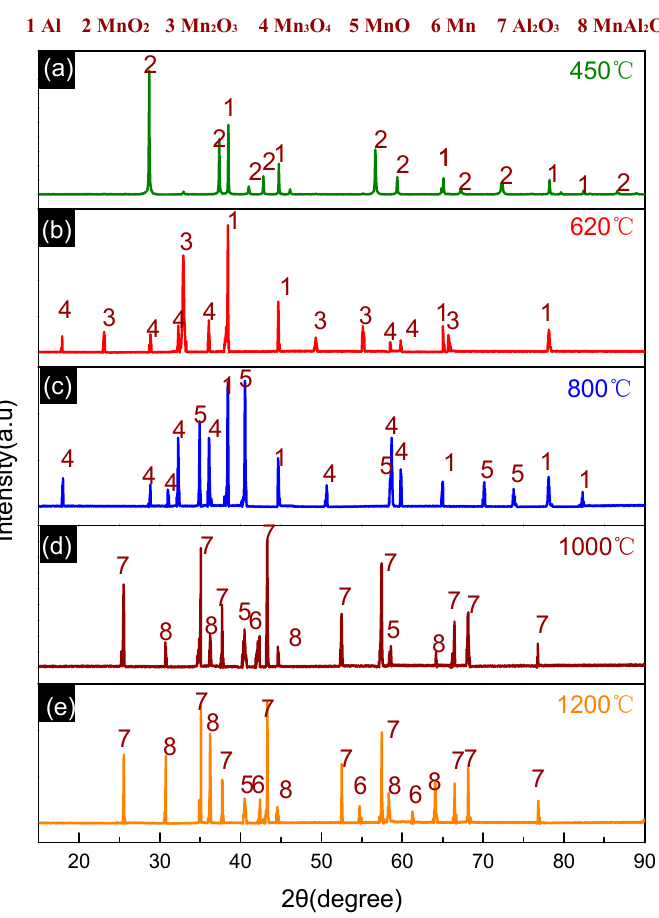
Figure 6. XRD patterns of Al/MnO 2 solid residues at different temperatures. ( a ) XRD patterns at 450 °C; ( b ) XRD patterns at 620 °C; ( c ) XRD patterns at 800 °C; ( d ) XRD patterns at 1000 °C; ( e ) XRD patterns at 1200 °C.